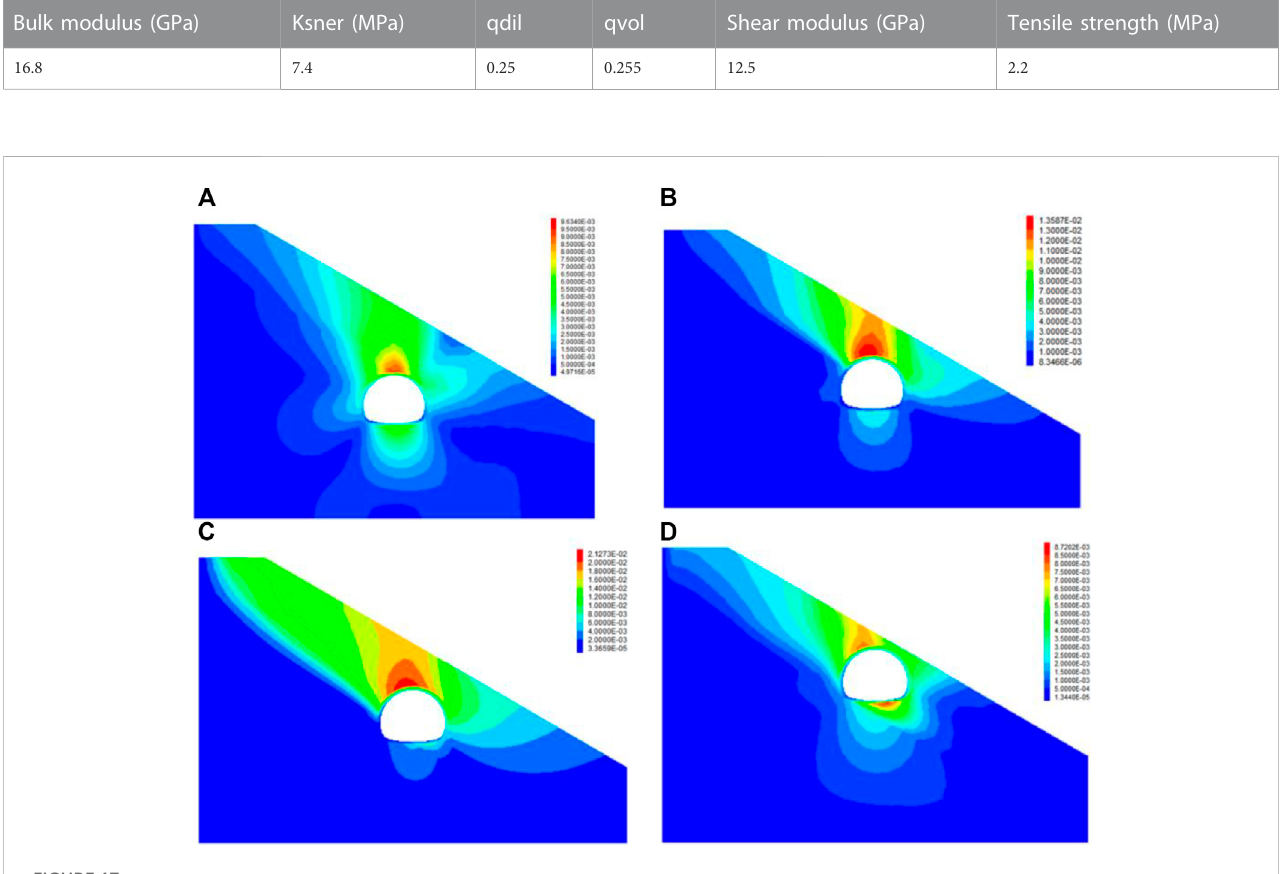
FIGURE 17 Surrounding rockdisplacementunderfourdifferentconditions: (A) Tunnelvaultcrossing thesoil – rockinterface; (B) Archhaunchcrossing thesoil – rock interface; (C) Arch spring crossing the soil – rock interface; and (D) Wall foot crossing the soil – rock